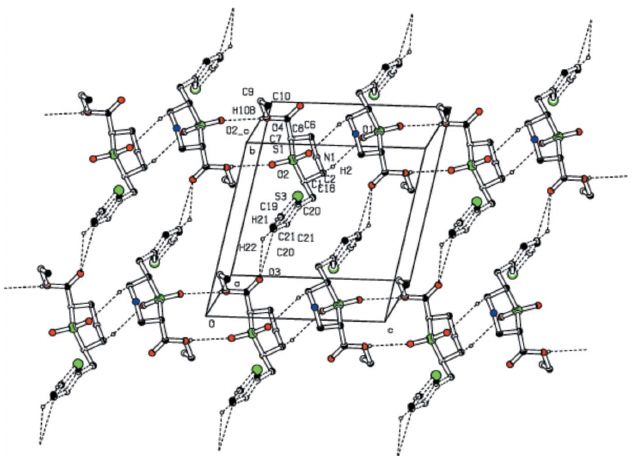
Figure 2 Aview of the molecular aggregation down the a axis. Ring systems and H atoms that are not involved in hydrogen bonding have been omitted for